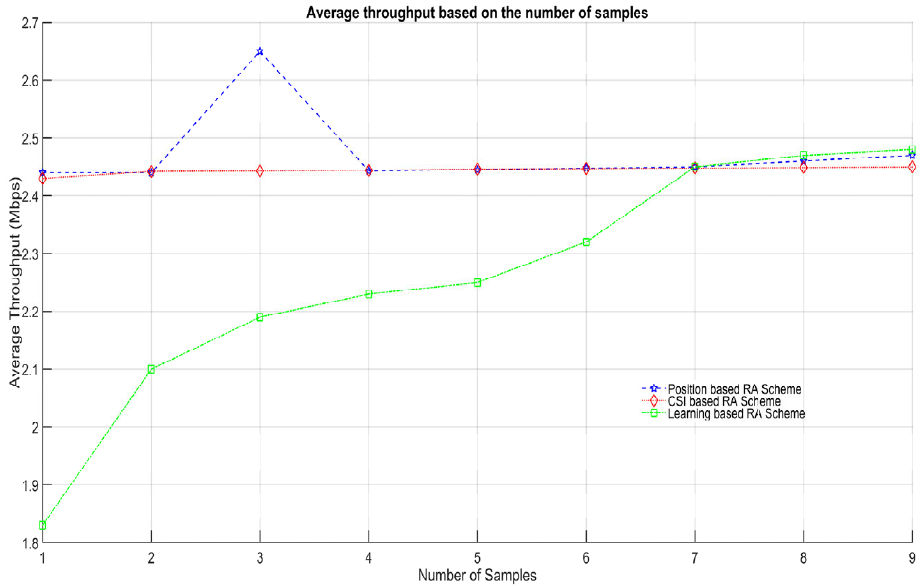
Figure 7. Average throughput based on the number of samples (in thousands).